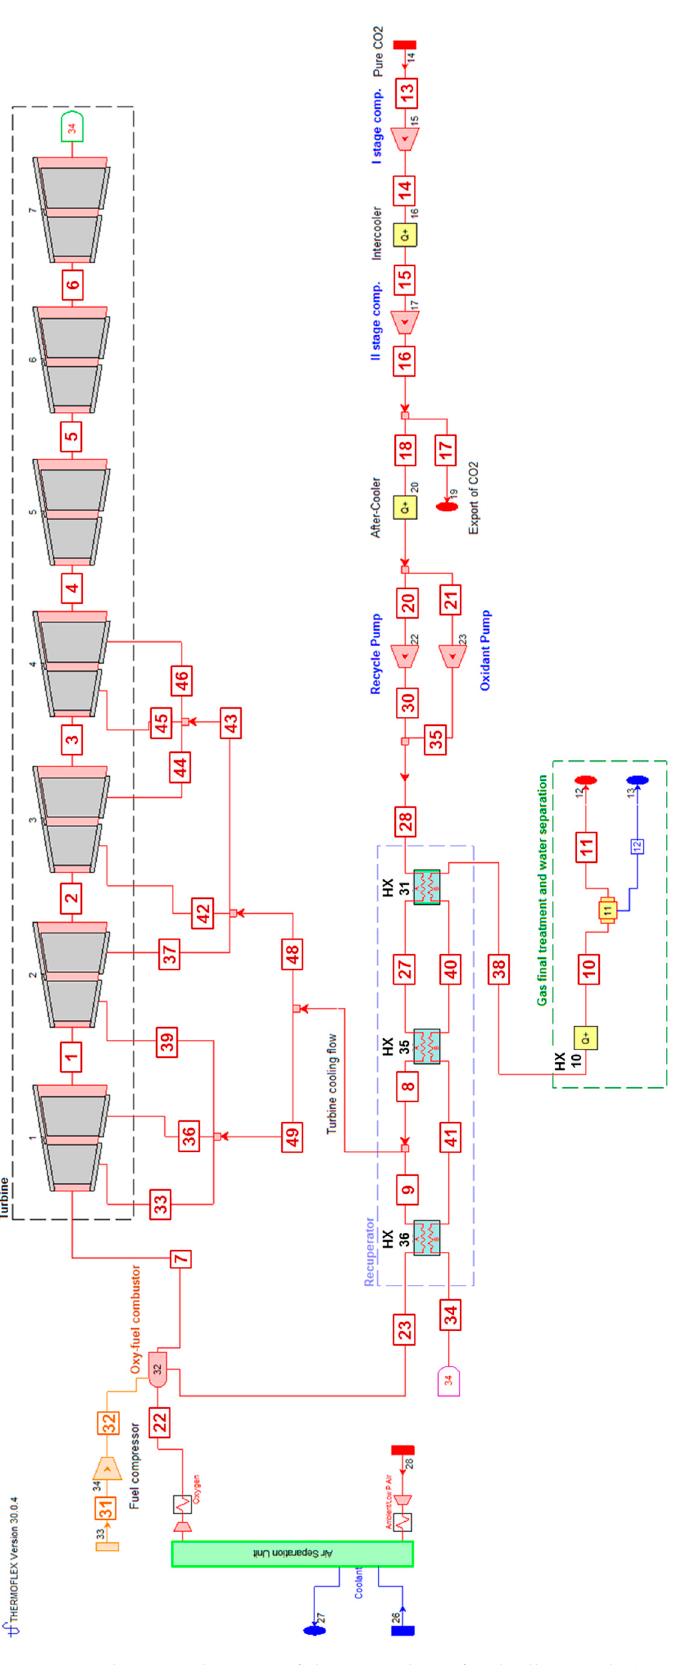
Figure 2. Schematic diagram of the natural gas-fired Allam cycle (component numbers are written in black; stream numbers are indicated in red/orange boxes).